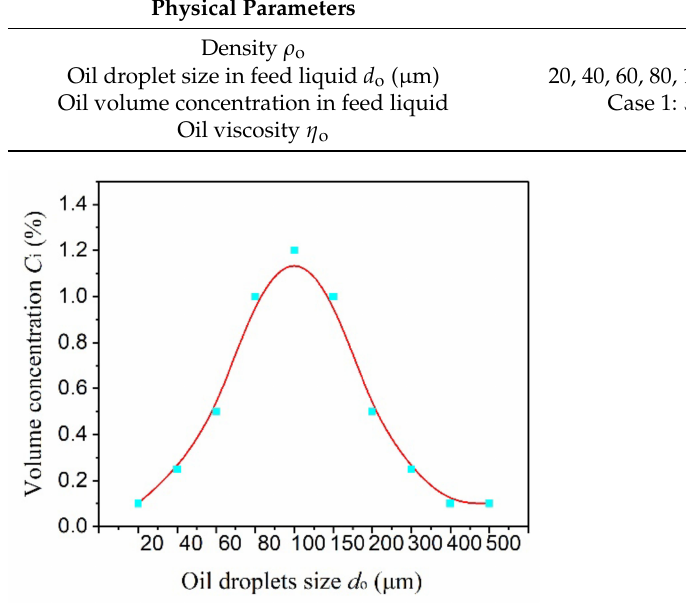
Figure 5. OC of each oil-droplet sizes with a total OC of 5%.